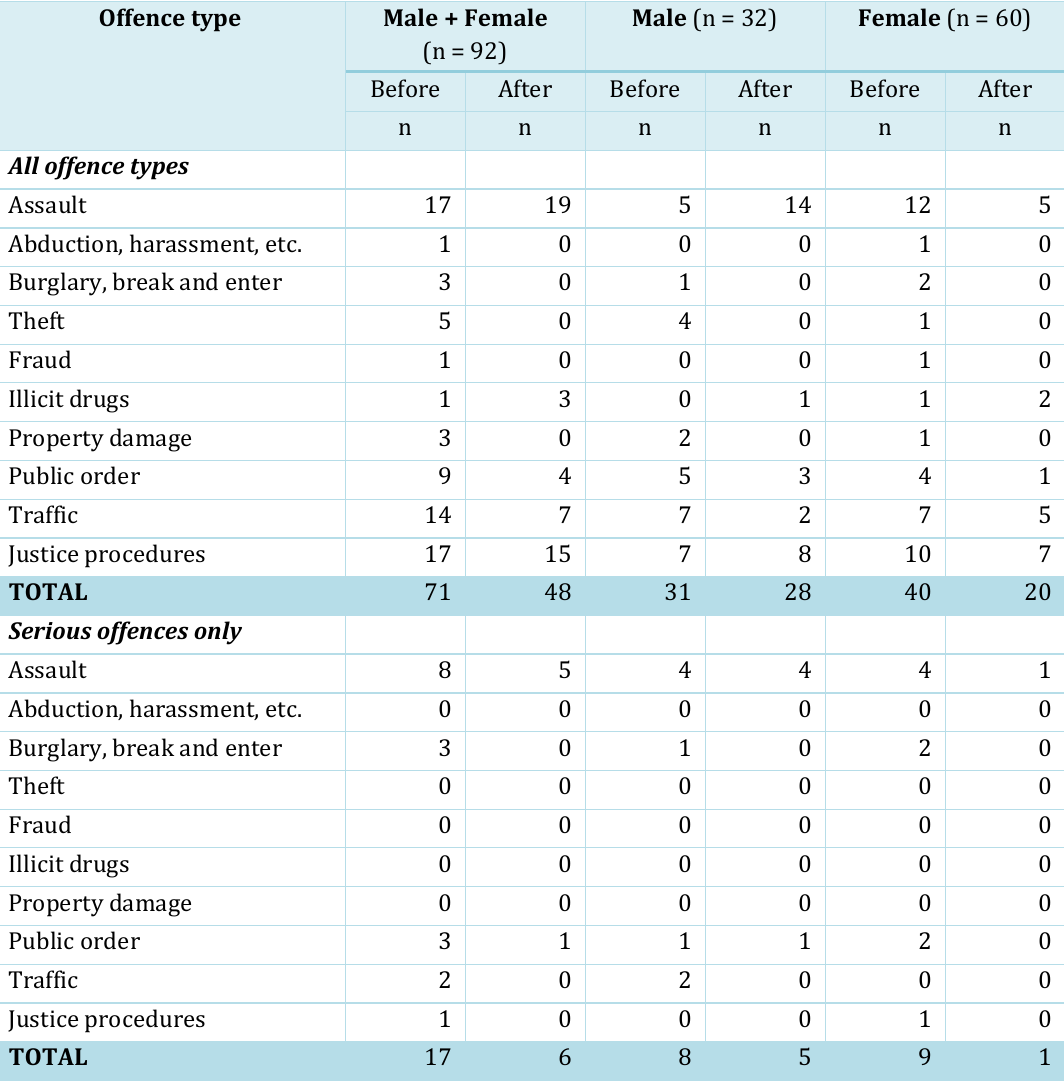
Table 1. Number of total and serious offences by Indigenous adult literacy campaign participants one year before compared to one year after the campaign in selected NSW communities, 2011 to 2018 Offence